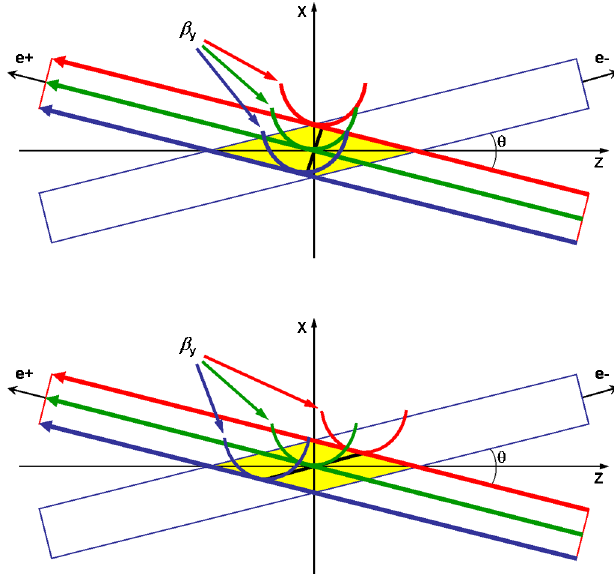
FIG. 2. Vertical beta function at IP without (on top) and with the CW transformation.